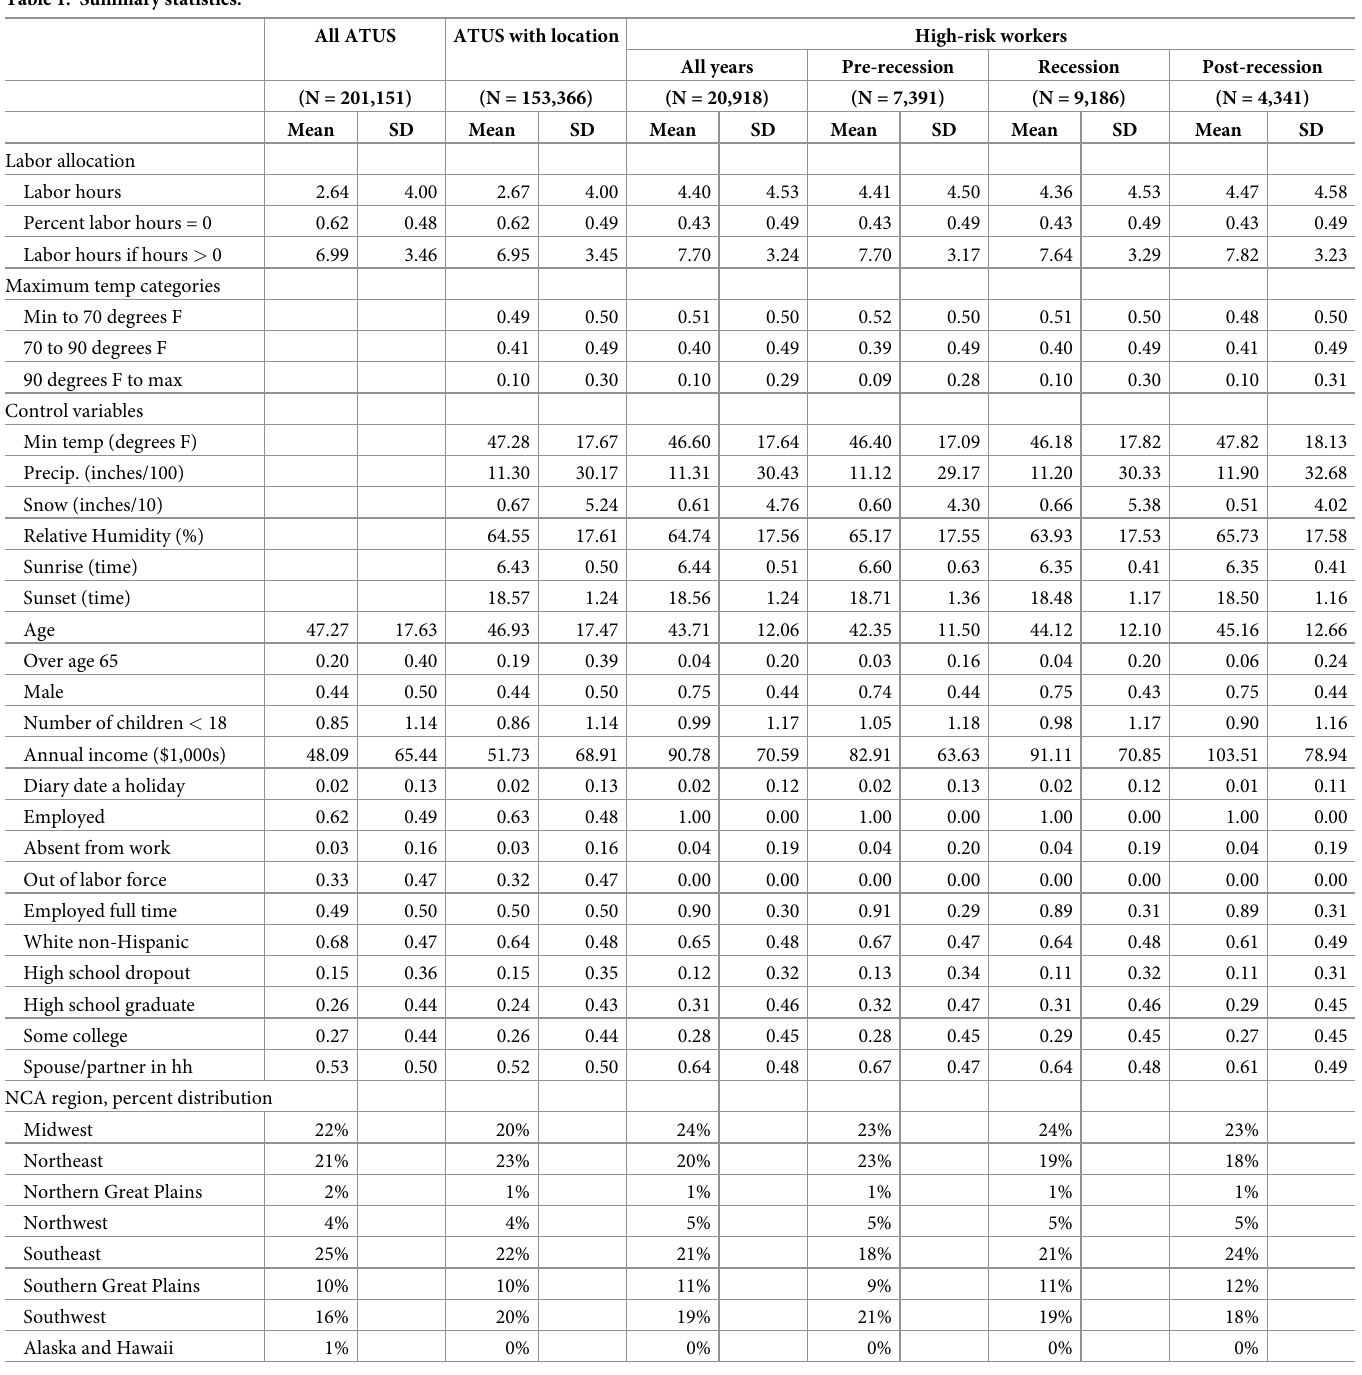
Table 1. Summary statistics.